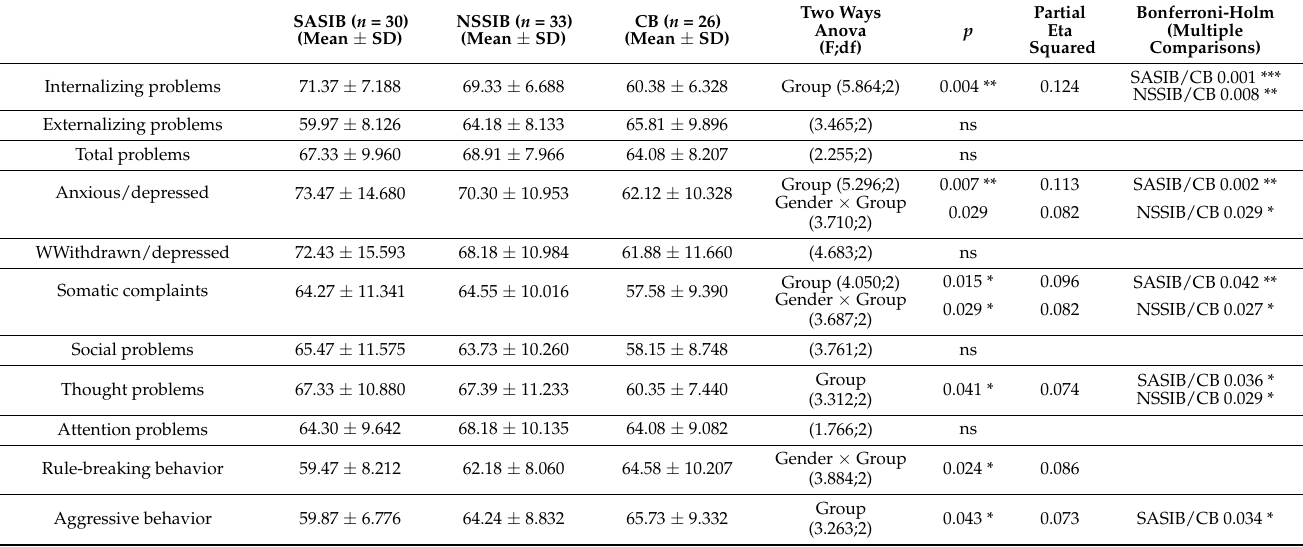
Table 2. Two-way ANOVA corrected by gender: Comparison between the three groups according to the Youth Self Report (YSR).